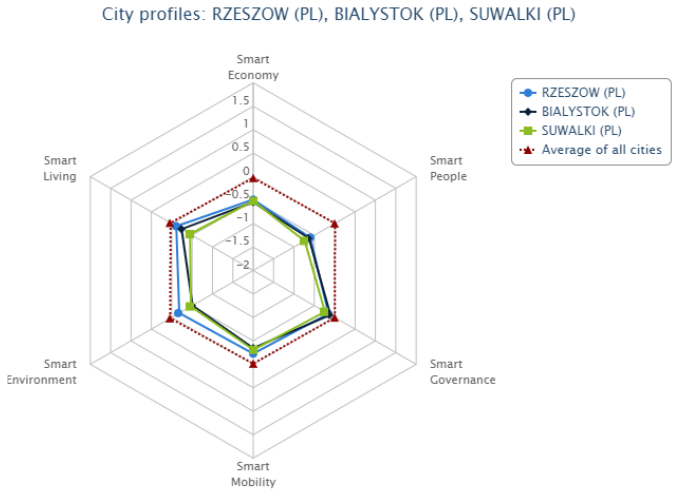
Figure 5. Benchmarking —Luxembourg, Aarhus, Suwałki , Rzeszów, Białystok, Suwałki in six smart city dimensions. Source: http://www.smart-cities.eu (accessed on 10 January 2023). The 4.0 version of the European Smart City ranking has been available since 2015.